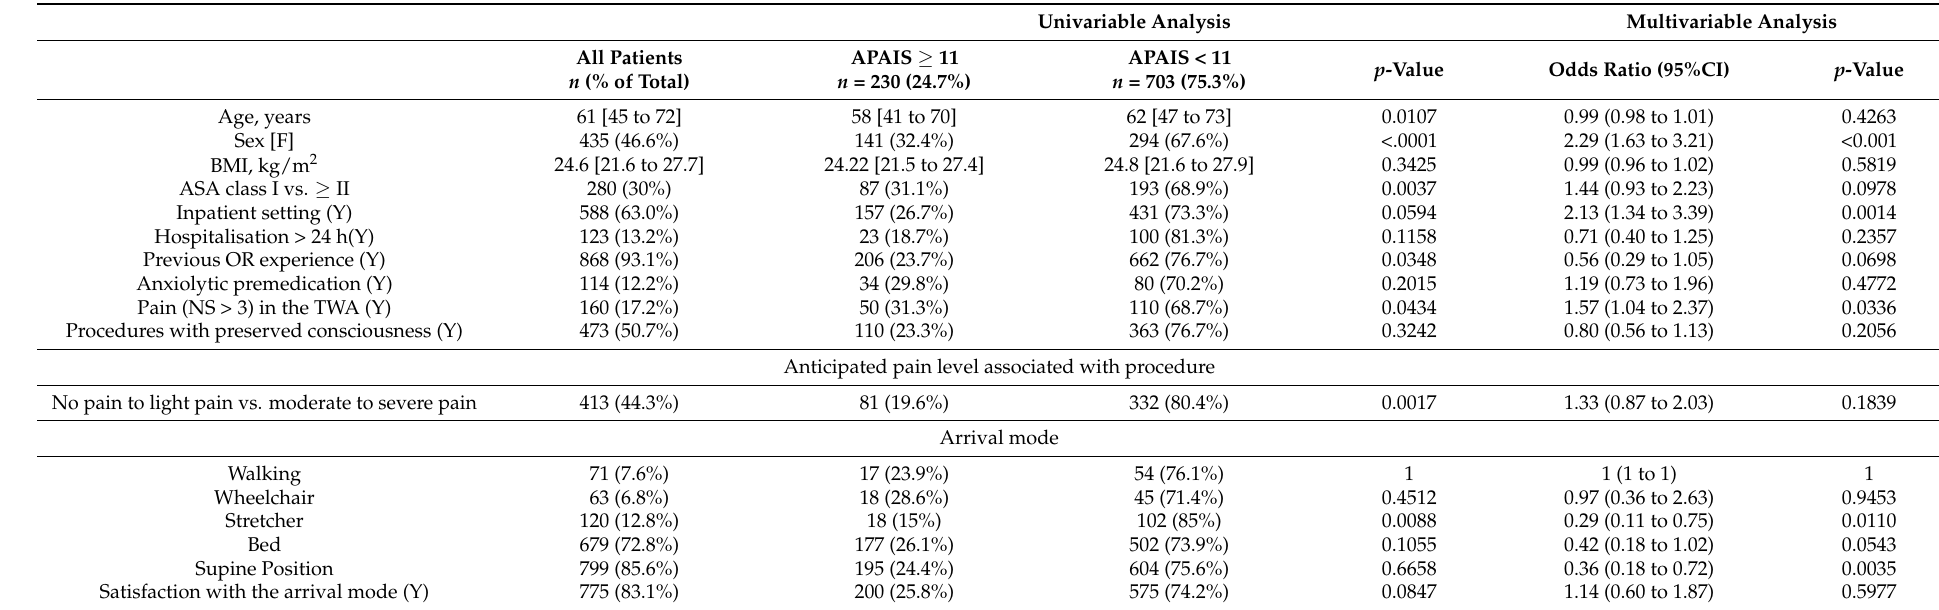
Table 2. Factors potentially associated with severe preoperative anxiety in the transfer and waiting area ( n = 933). Univariable Analysis Multivariable